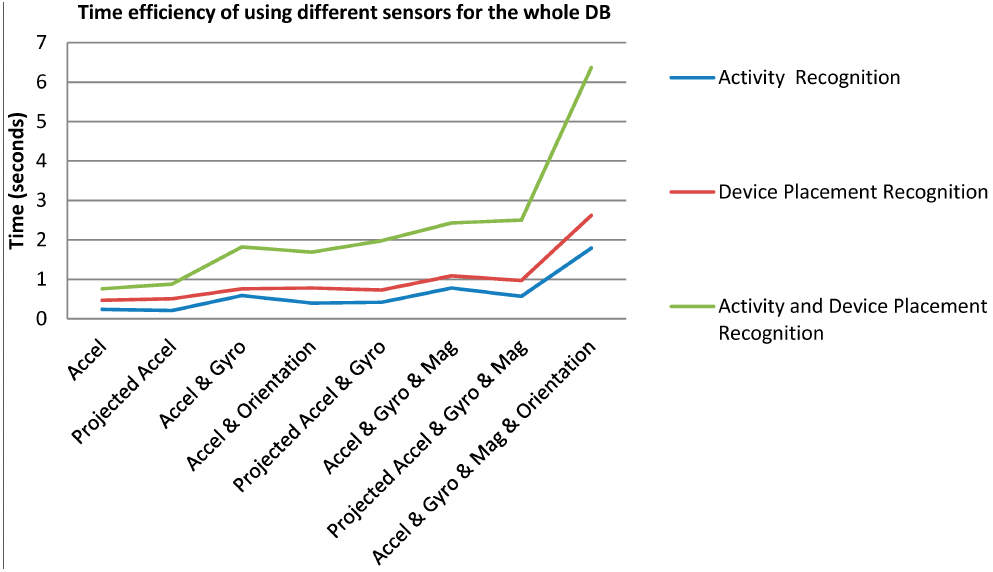
Figure 8. Time consumption of using different sensors for different activities modes (Classifier: BN, Number of features: 46).